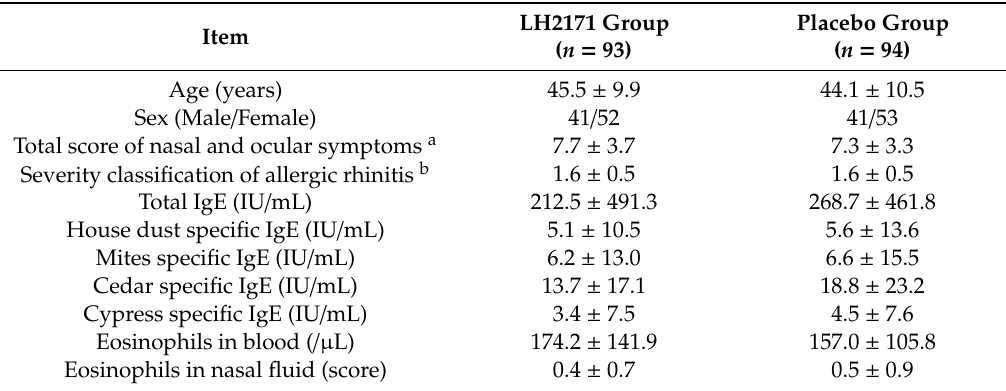
Table 2. Background information on the per-protocol dataset.